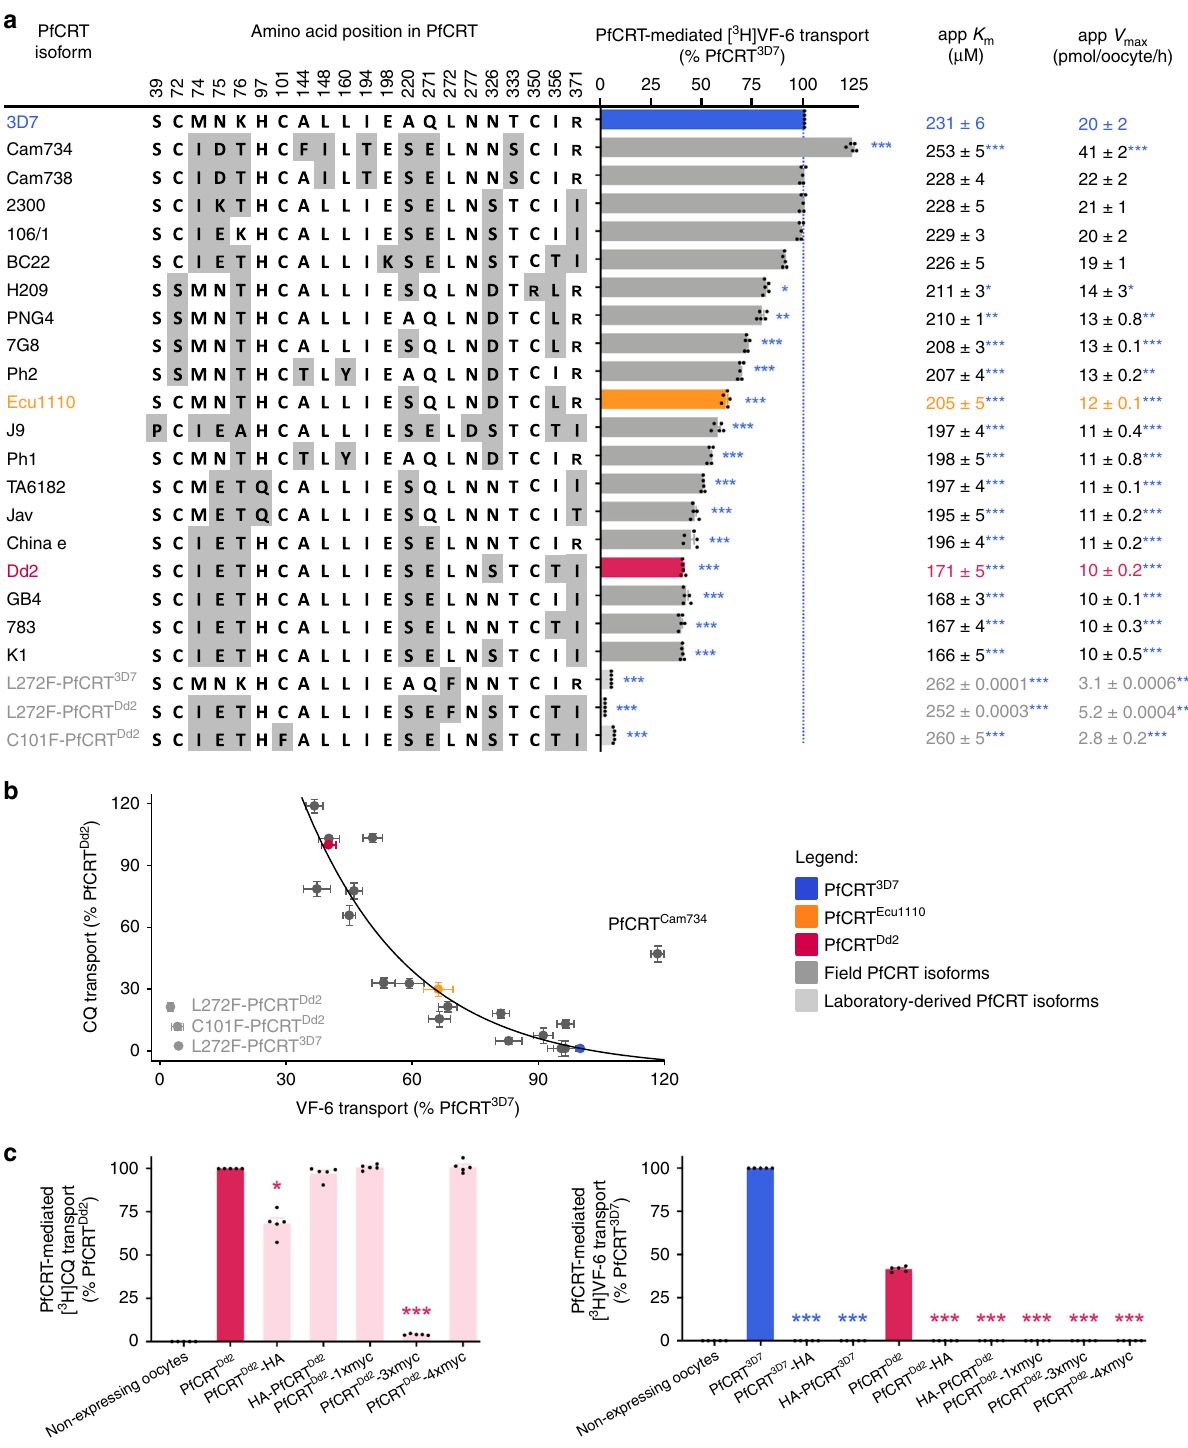
Fig. 4 Diverse fi eld and laboratory-derived isoforms of PfCRT transport the VF-6 peptide. a The VF-6 transport activities, including kinetic parameters, of various fi eld and laboratory-derived PfCRT isoforms in Xenopus oocytes ( K m , Michaelis – Menten constant; V max , maximum velocity). b The capacity of PfCRT to transport VF-6 decays exponentially as the protein ’ s CQ transport activity increases ( R 2 = 0.93). Exceptions to this trend include PfCRT Cam734 , L272F-PfCRT Dd2 , L272F-PfCRT 3D7 and C101F-PfCRT Dd2 . c [ 3 H]CQ transport (left) and [ 3 H]VF-6 transport (right) via epitope-tagged versions of PfCRT 3D7 and PfCRT Dd2 . The version of PfCRT Dd2 carrying a C-terminal 3xmyc tag does not mediate [ 3 H]CQ transport. The other four variants of PfCRT Dd2 retain all or most of their CQ transport activity. By contrast, none of the tagged versions of PfCRT 3D7 or PfCRT Dd2 transport [ 3 H]VF-6. The fusion of polypeptides to PfCRT can therefore abolish its ability to transport peptides, even when the protein remains able to transport CQ. The data are the mean of n = 5 independent experiments (each yielding similar results and overlaid as individual data points in a and c ), and the error is the SEM. Where not visible, the error bars fall within the symbols. The asterisks denote a signi fi cant difference from the relevant PfCRT Dd2 (red asterisks) or PfCRT 3D7 (blue asterisks) control; * P < 0.05, ** P < 0.01, *** P < 0.001 (one-way ANOVA). The source datasets are provided as a Source Data fi